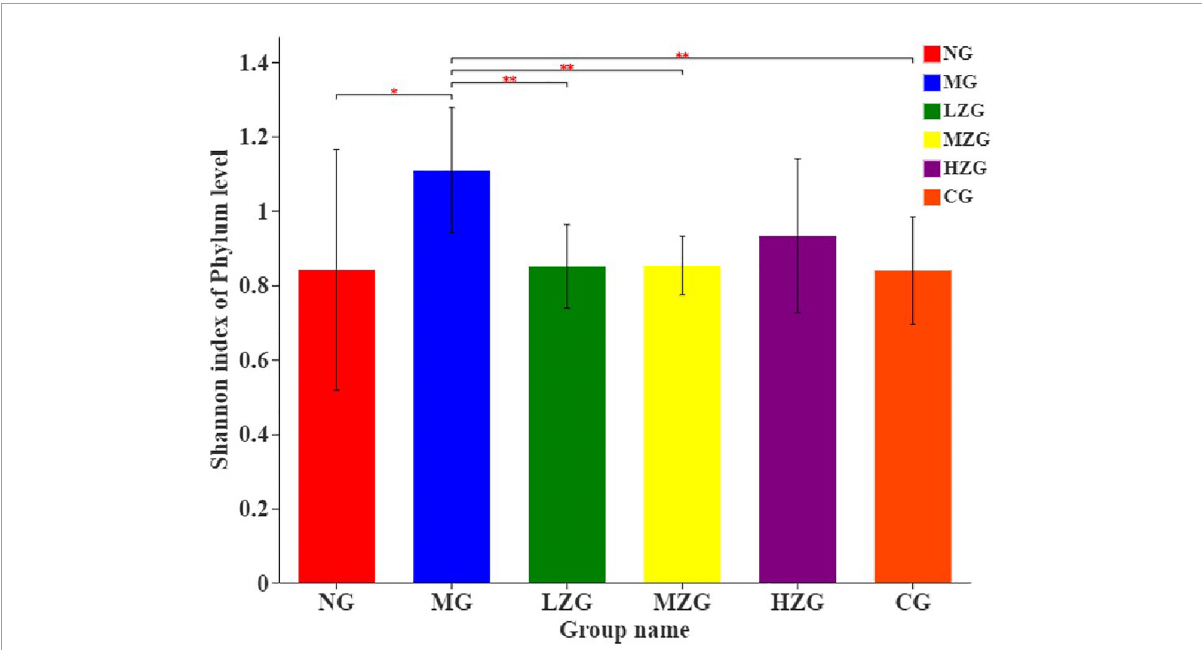
FIGURE8 Alpha diversity analysis of the gut microbiota. The abscissa is the name of the group, and the ordinate is the average value of the index of each group. This figure shows the significant differences between the selected two groups of samples, and marks the two groups with significant differences. “*” means P < 0.05, “**” means P <